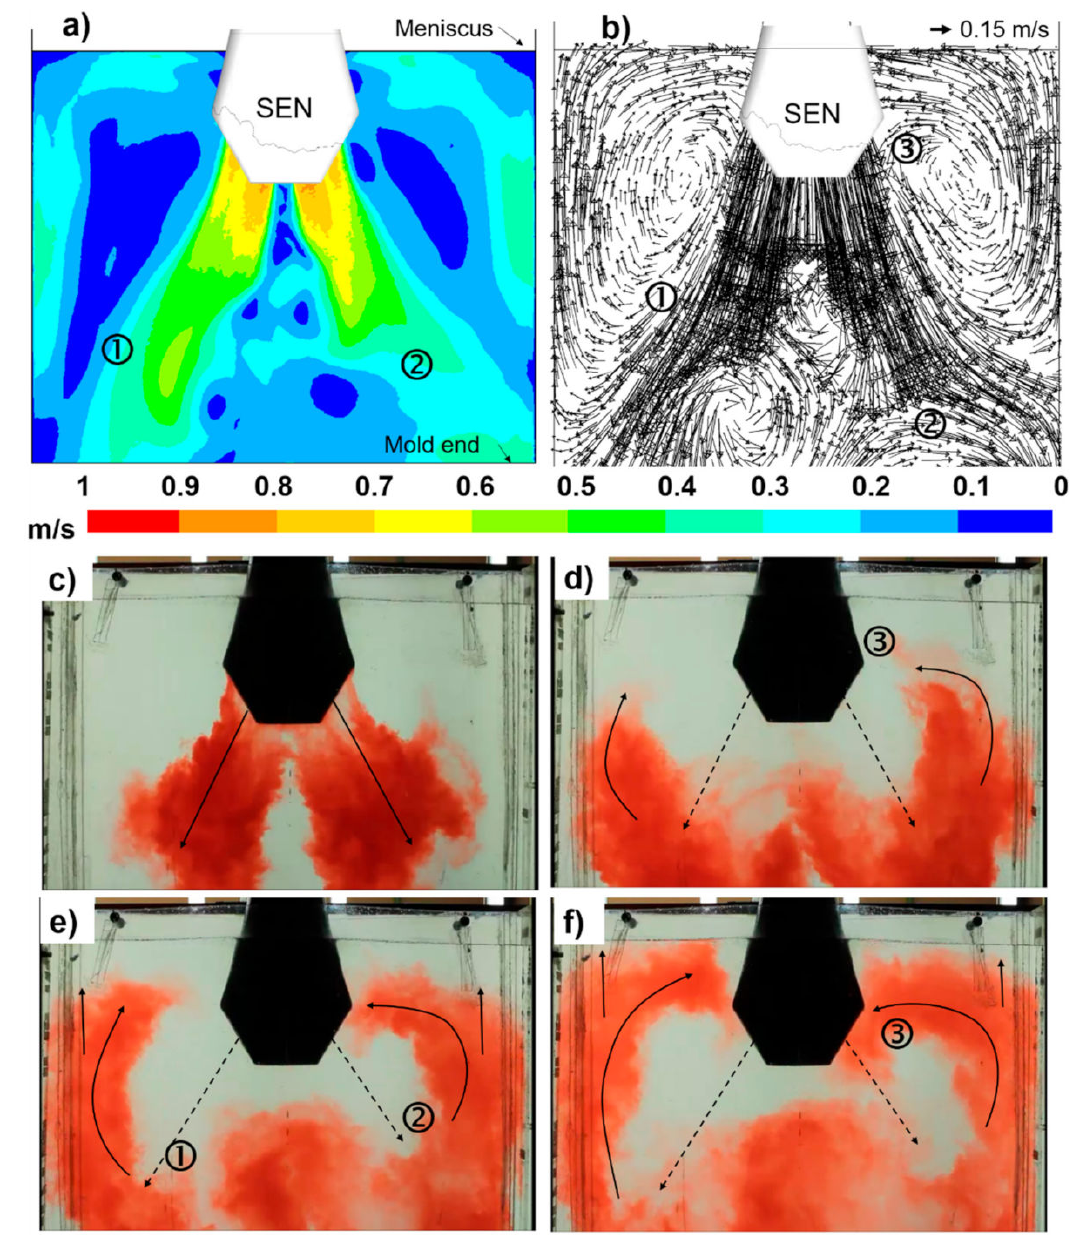
Figure 3. Model validation, mathematical (( a ) velocity contours, ( b ) velocity vectors profile) and physical flow patterns of the mold (tracer injection at di ff erent times, ( c ) 5s, ( d ) 6s, ( e ) 7s, ( f )